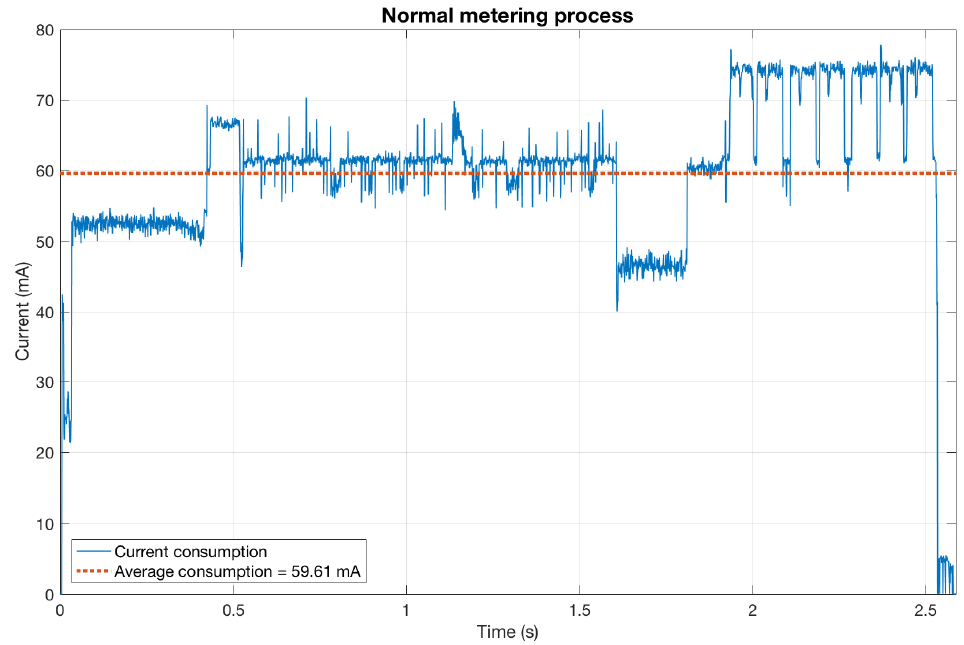
Figure A1. Detailed consumption for the device when a normal metering process occurs.